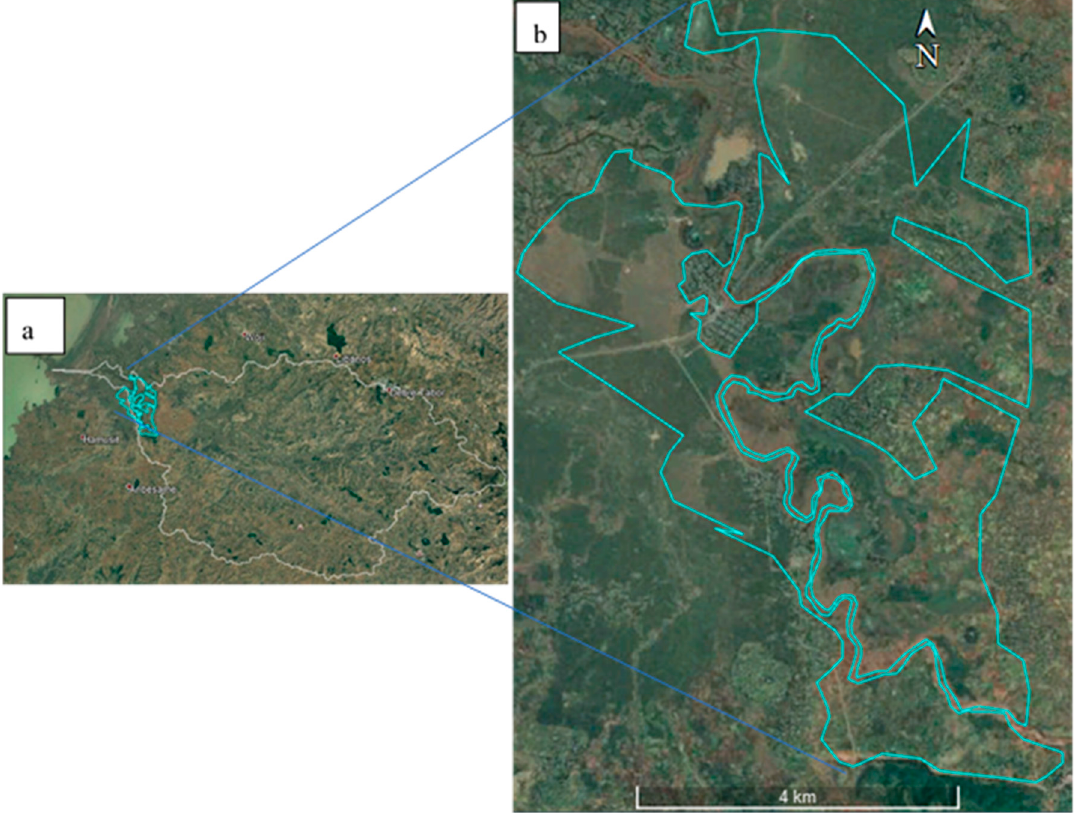
Figure 7. Gumara watershed ( a ) and Pump irrigation sites between the bridge and Wanzaye town ( b ); taken from Google Earth of 2019 image. The blue line indicates the total irrigation area (29 km 2 ) where the net irrigated area is 15.25 km 2.